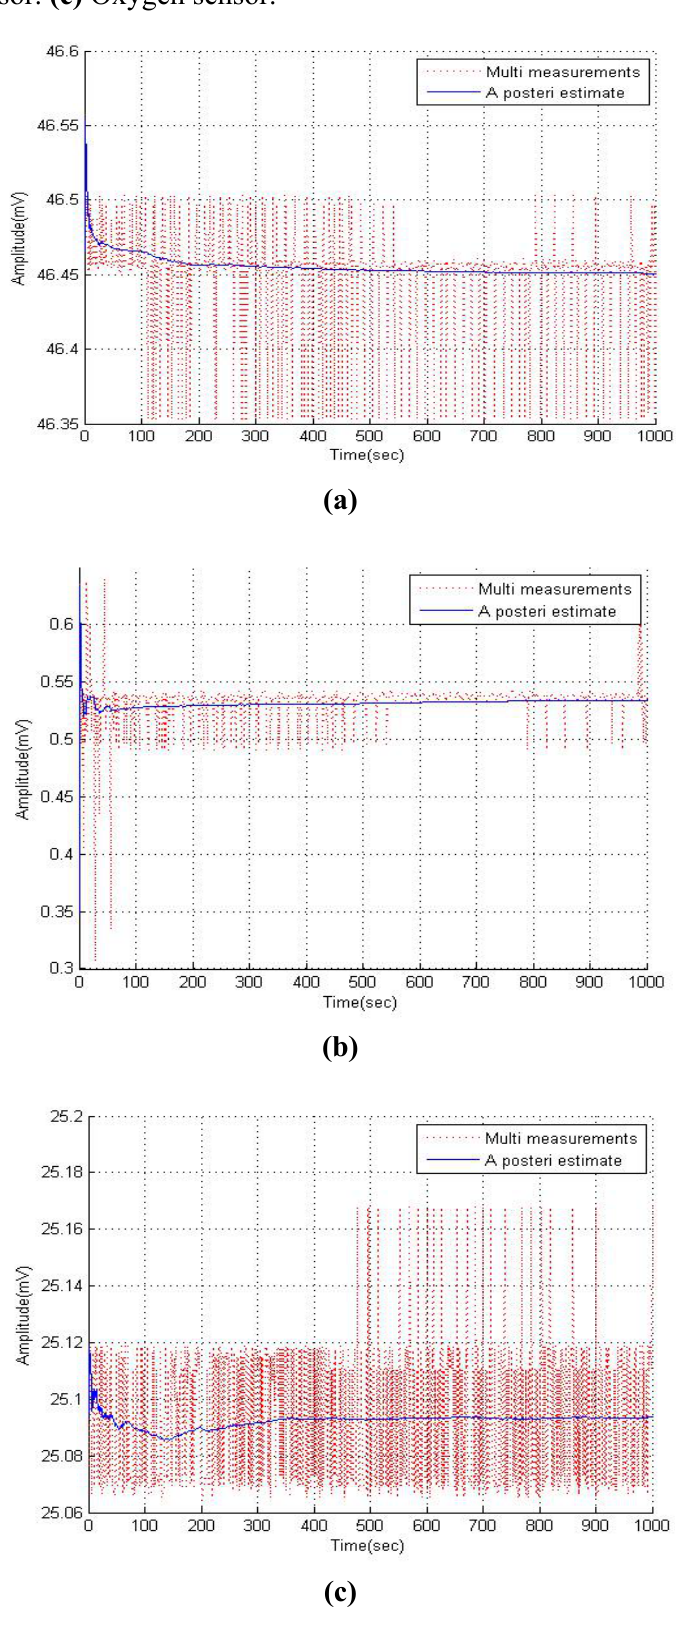
Figure 9. Experimental results of the improved Kalman filter. (a) Temperature sensor. (b) Humidity sensor. (c) Oxygen